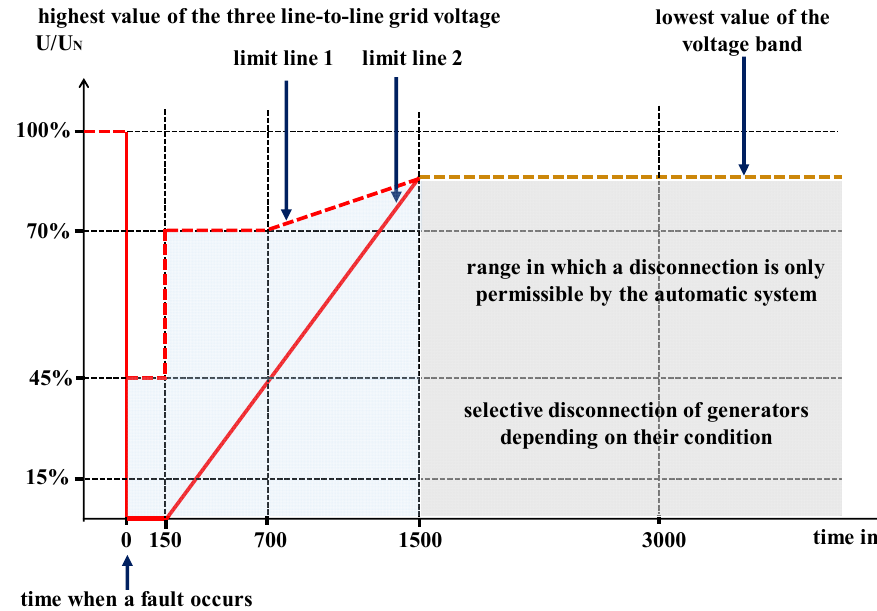
Figure 16. Low voltage ride through (LVRT) requirement for wind farm (WF).